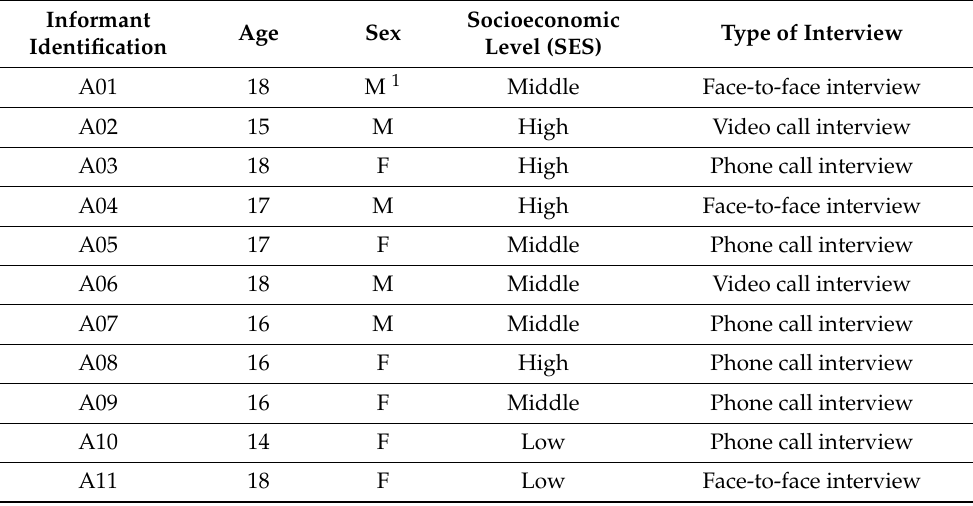
Table 1. Summary table of informants and